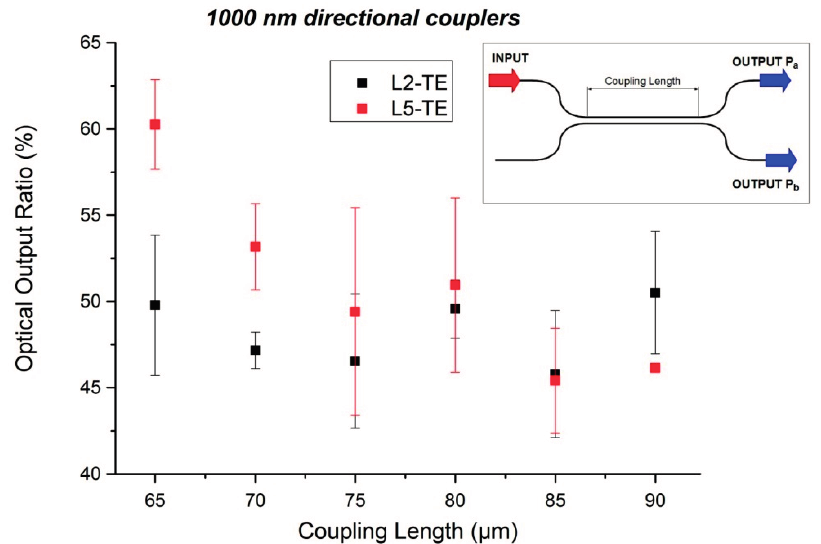
Figure 5. Optical characterization of the directional coupler for L2 and L5 samples. The optical output ratio represents the optical power at the output waveguide (P a ) versus the sum of the optical power of both output waveguides (P a + P b ). ( inset ) Scheme of a directional coupler.